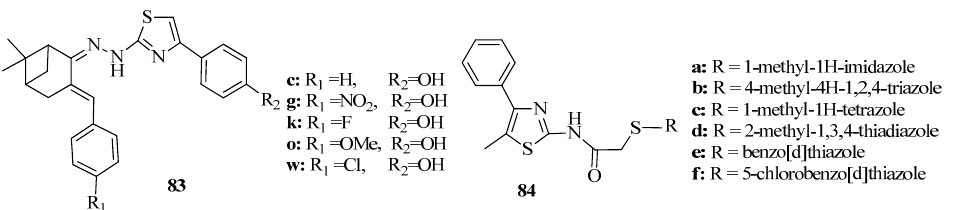
Figure 32. Structures of β -pinene-based thiazole derivatives and N-(5-methyl-4-phenylthiazol-2-yl)-2-(substituted thio) acetamides.